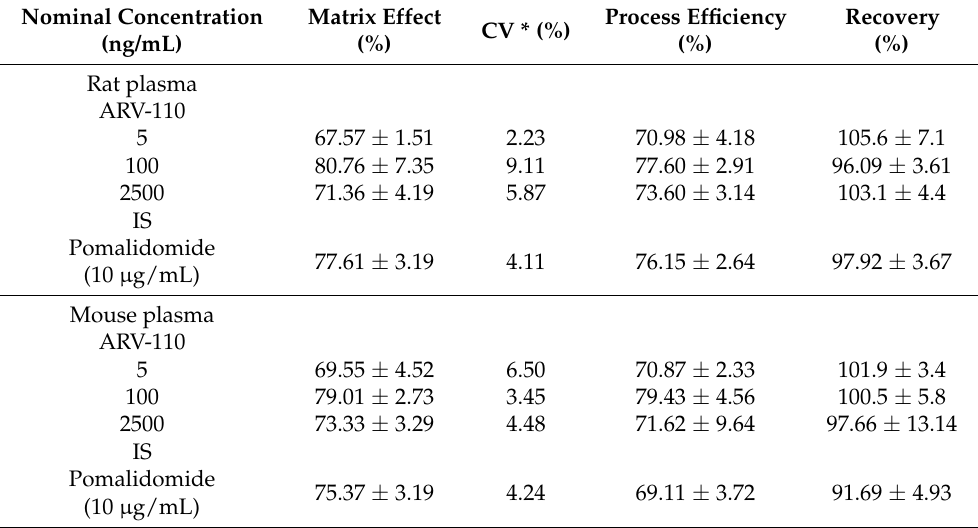
Table 3. Stability of ARV-110 in rat and mouse plasma (mean ± SD, n = 4).